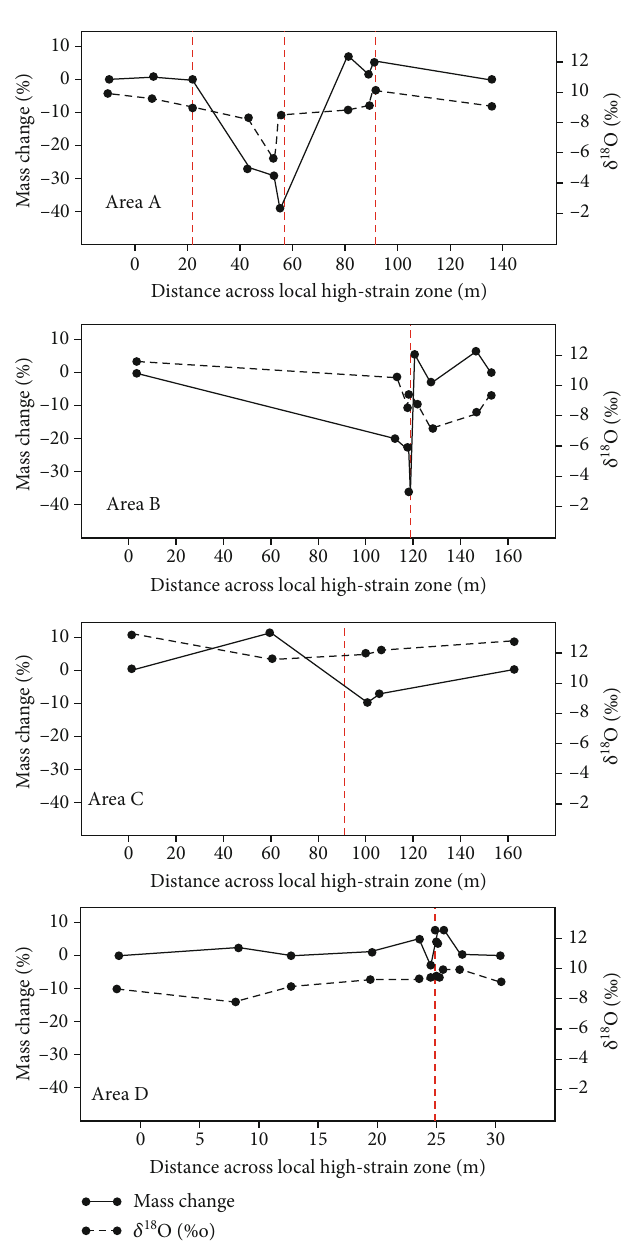
Figure 10: Mass changes and δ 18 O values against distance (0 = northern end of transect) across the local high-strain zones in areas A-D. The dashed red lines represent the cores of local high-strain